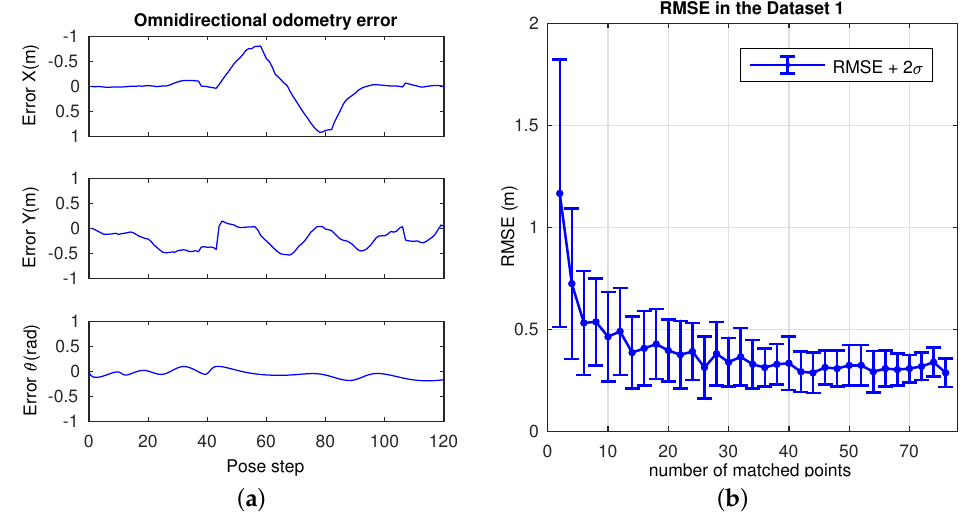
Figure 14. Omnidirectional odometry results in Dataset 1. ( a ) error in X , Y and θ ; ( b ) RMSE (m) with 2 σ versus the number of matched